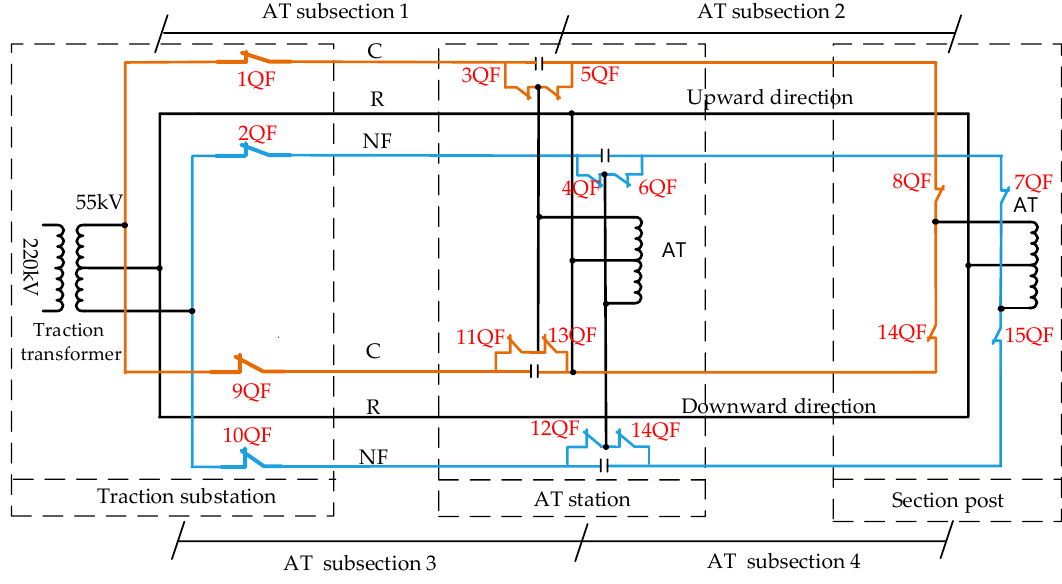
Figure 2. Simplified diagram of the novel segmental all parallel AT TPSS with four subsections.